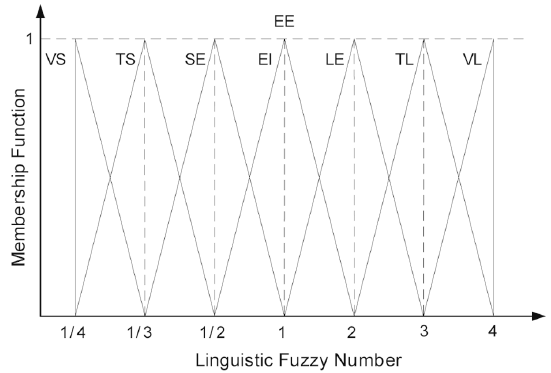
Fig. 2. Graphical representation of triangular membership function for importance